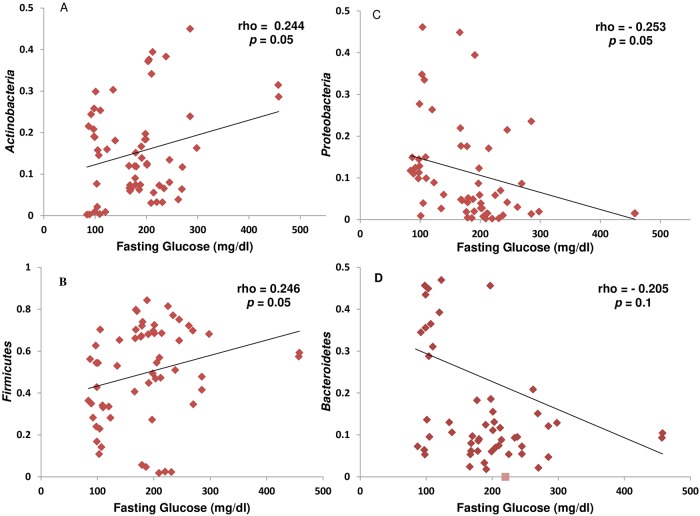
Correlations between fasting glucose and gut microbiota in fecal samples of participants.Spearman’s rank correlation coefficient was used to analyze the correlation between obese-T2DM (n = 40) and healthy (n = 20). (A) Correlation between fasting glucose and phylum Actinobacteria. (B) Correlation between fasting glucose and phylum Firmicutes (ρ = 0.246, p = 0.05). (C) Correlation between fasting glucose and phylum Proteobacteria (ρ = -0.253, p = 0.05). (D) Correlation between fasting glucose and Bacteroidetes (ρ = -0.205, p = 0.11).